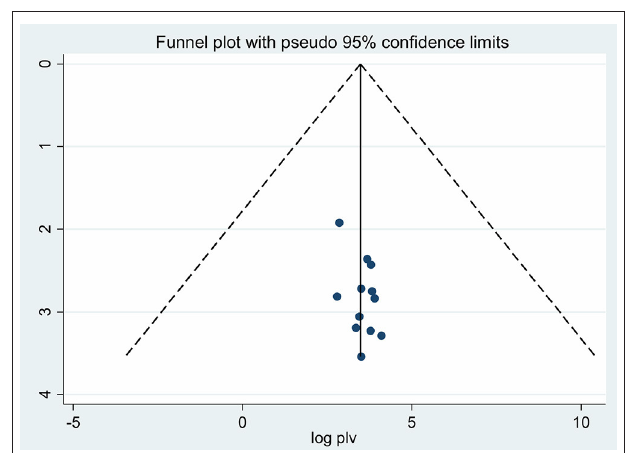
FIGURE 4 | Funnel plot to test the publication bias in 12 studies with 95% confidence